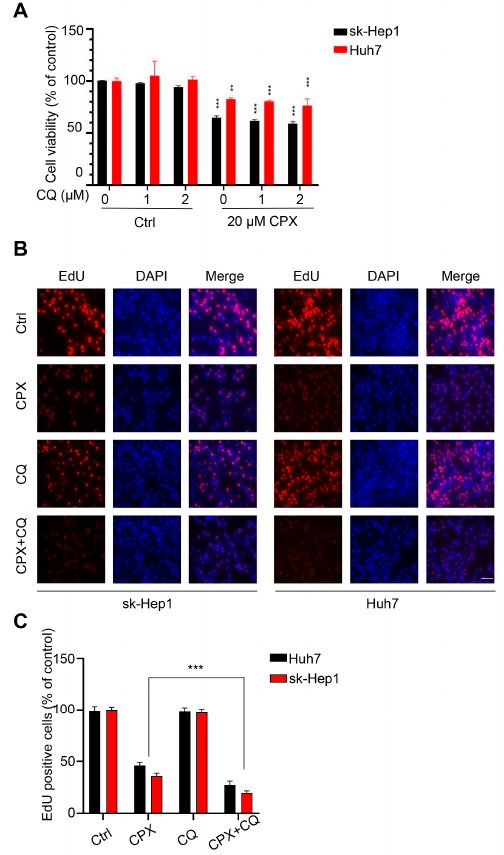
Figure 4. Autophagy attenuates CPX-induced anti-cancer effects. ( A ) The CCK8 assay detected cell viability of sk-Hep1 and Huh7 cells treated with the indicated concentrations of CQ with or without 20 µ M CPX for 24 h. ( B , C ) The EdU assay detected proliferation of sk-Hep1 and Huh7 cells treated with 1 µ M CQ in the presence or absence of CPX (20 µ M) for 24 h. The EdU positive cell rate was quantitated. Data are means ± s.d. and are representative of 3 independent experiments. **, p < 0.01, ***, p < 0.001. Statistical significance compared with respective control